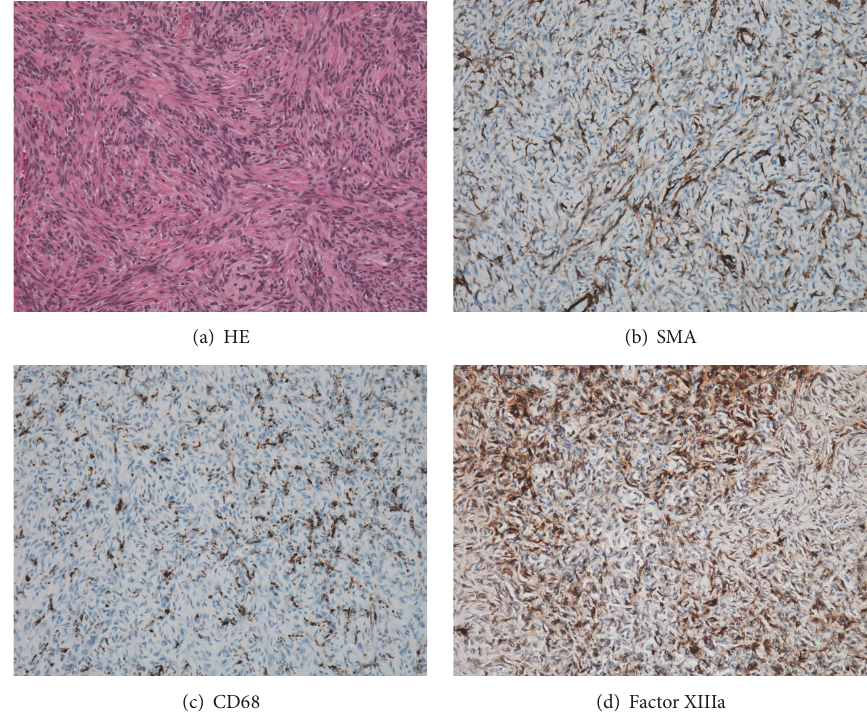
Figure 3: (a) Proliferation of spindle cells with vague storiform growth pattern and basal cell hyperplasia of overlying epidermal cells noted on hematoxylin and eosin staining. (b–d) Immunohistochemical stain showing positivity for (b) SMA, (c) CD 68, and (d) factor